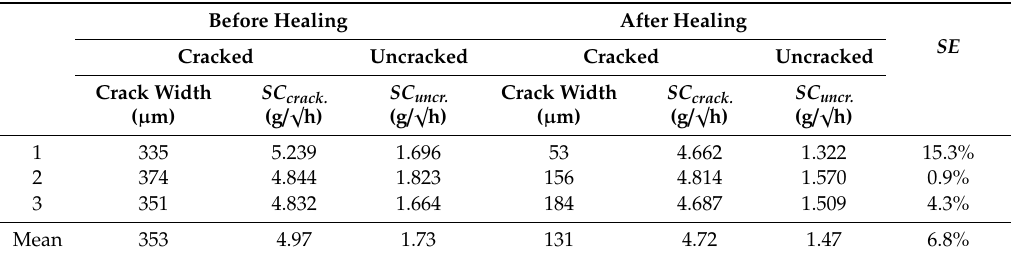
Figure 14. Mean cumulative water uptake in function of the square root of time of both cracked and uncracked specimens before and after healing. The length of the error bars represent two times the standard deviation. Table 3. Sorption coefficient and crack width of cracked specimens before and after healing, as well as sorption coefficient of uncracked specimens after healing, and sealing efficiency 𝑆𝐸 .